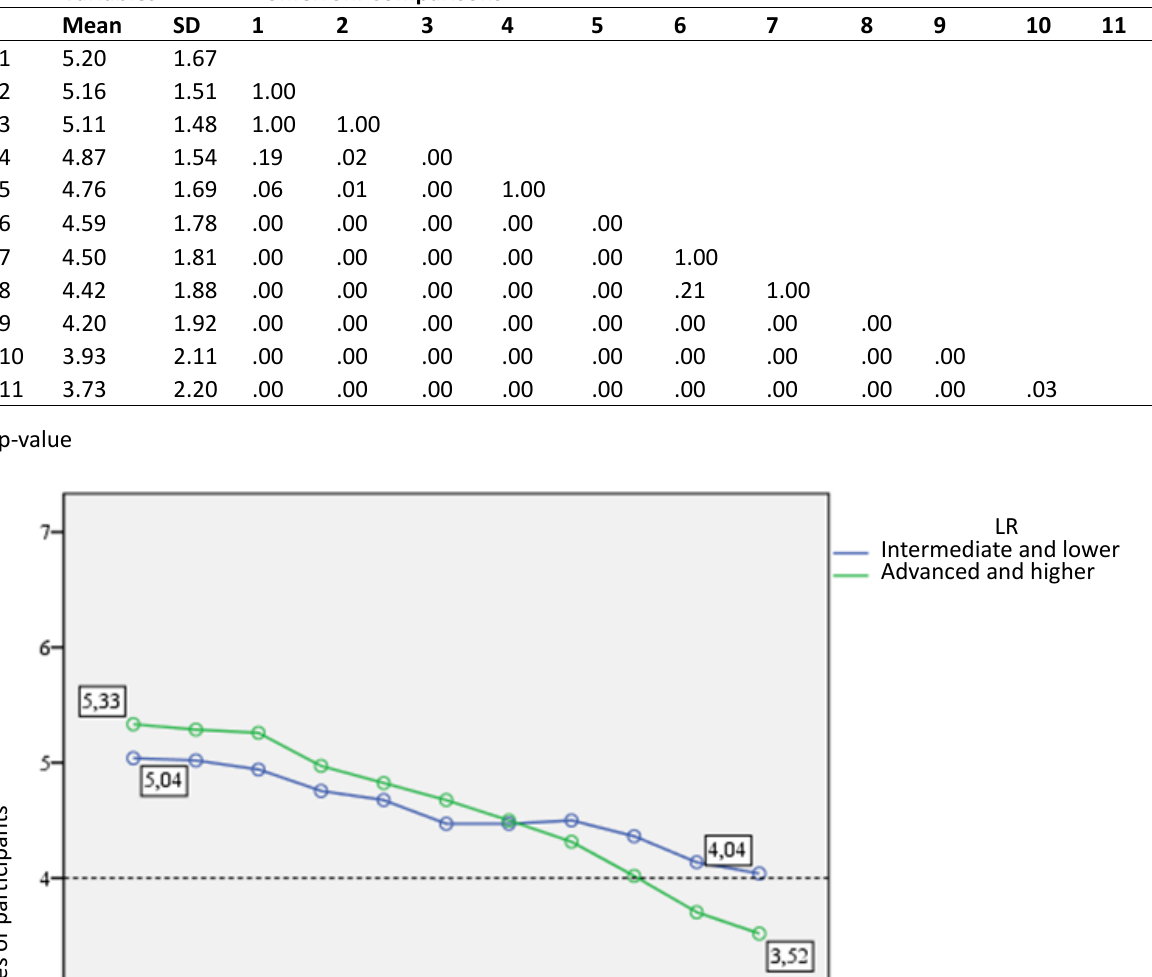
Table 4. ANOVA Comparisons of Visual Climbing Preferences of Participants on the basis of Chalk Effect